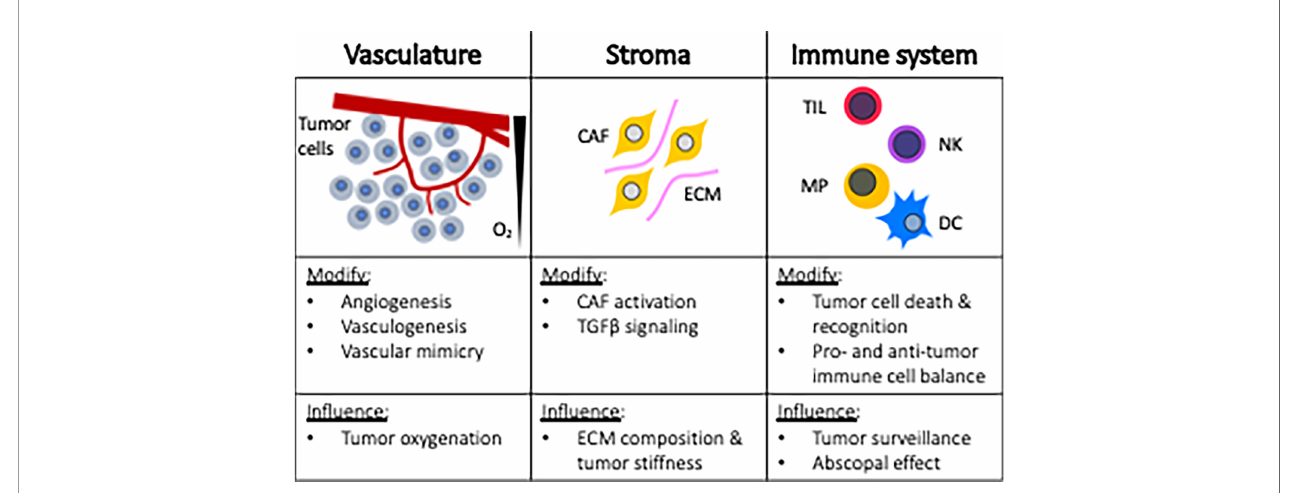
FIGURE 2 | Microenvironmental targets for radiosensitization strategies. CAF, cancer associated fi broblast; ECM, extracellular matrix; TIL, tumor in fi ltrating lymphocytes; NK, natural killer; MP, macrophage; DC, dendritic